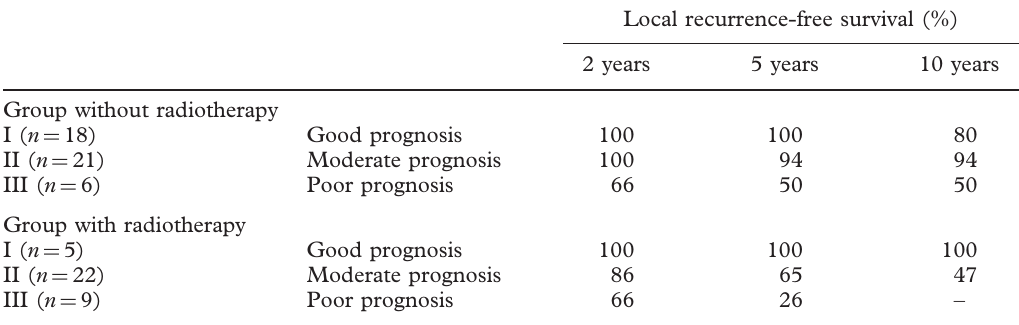
Group I, grade I and no complication; group II, grade II/III or complication; and group III, grade II/III and